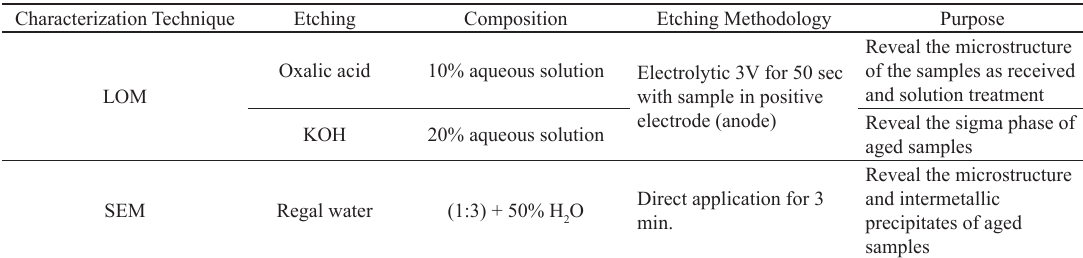
Table 3. Etching employed to LOM and SEM analysis. Characterization Technique